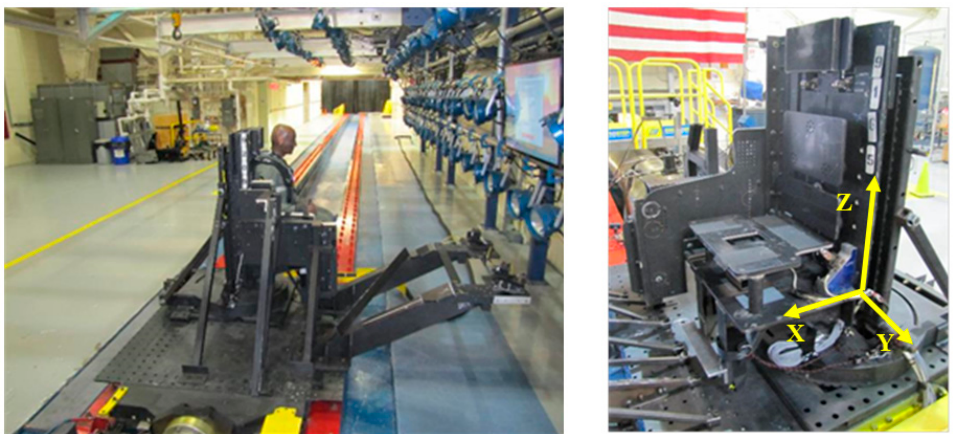
Figure 1. Air Force Research Laboratory (AFRL) horizontal sled facility and lateral impact seat